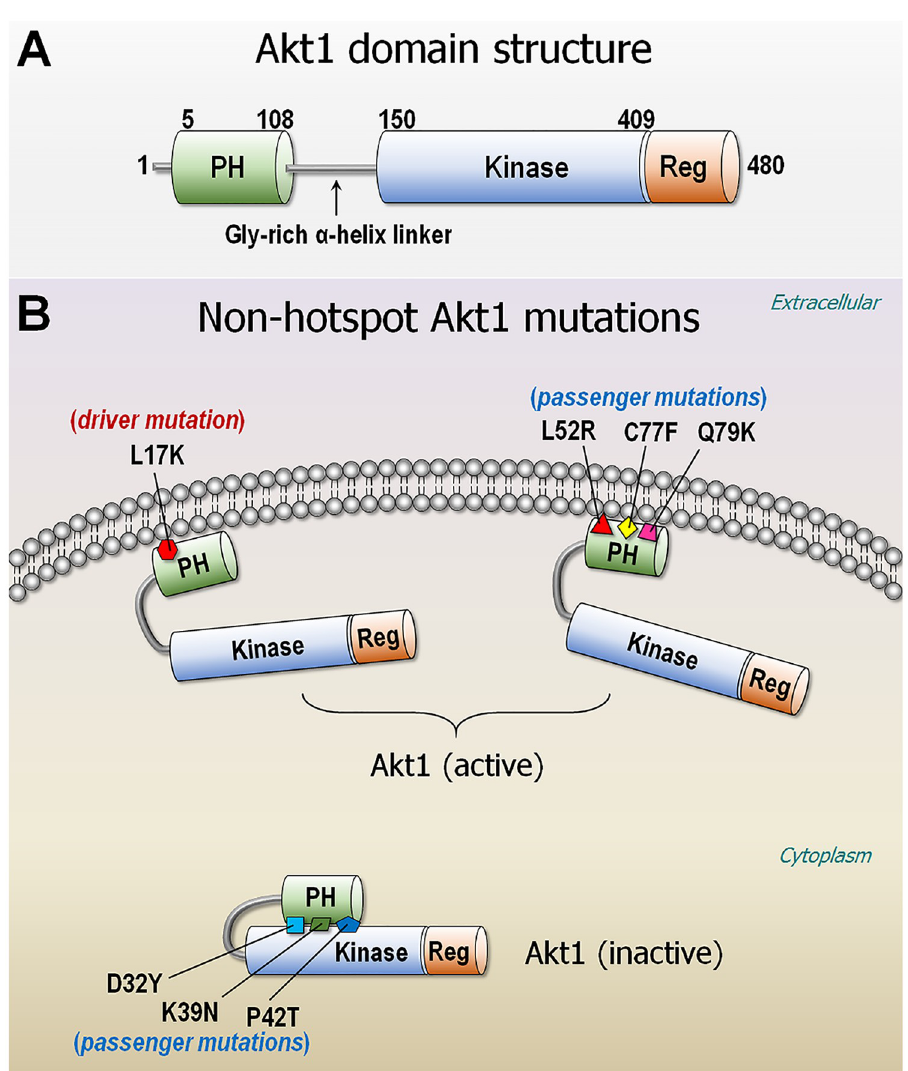
Fig 9. Akt1 domain structure. (A) Akt1 is composed of PH (residues 5–108), kinase domain (residues 150–408), and regulatory domain (residues 409–480). The Gly-rich α -helix linker connects the PH and kinase domains. (B) Non- hotspot, passenger mutations can be functional as the driver mutation E17K. The PH domain mutants, L52R, C77F, and Q79K activate Akt1 as the E17K driver does, whereas D32Y, K39N, and P42T mutants at the interface between the PH and kinase domains reduce Akt1 in the inactive conformation. PH, pleckstrin